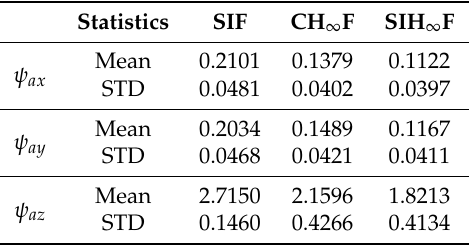
Table 2. Statistics of RMSE for 50 Monte Carlo simulations ( ◦ ).